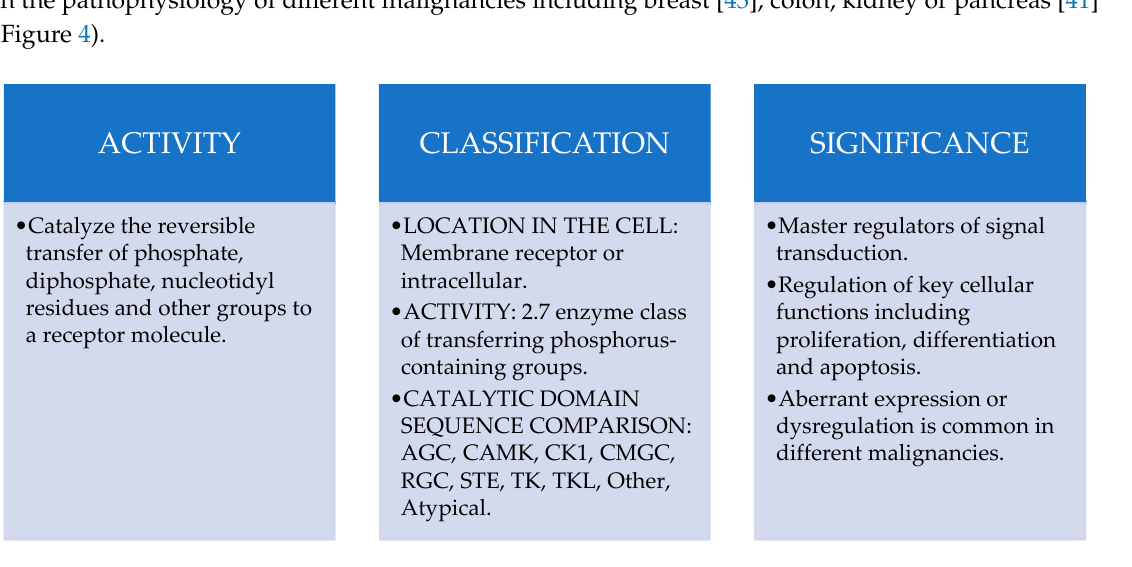
Figure 4. Protein kinases overview